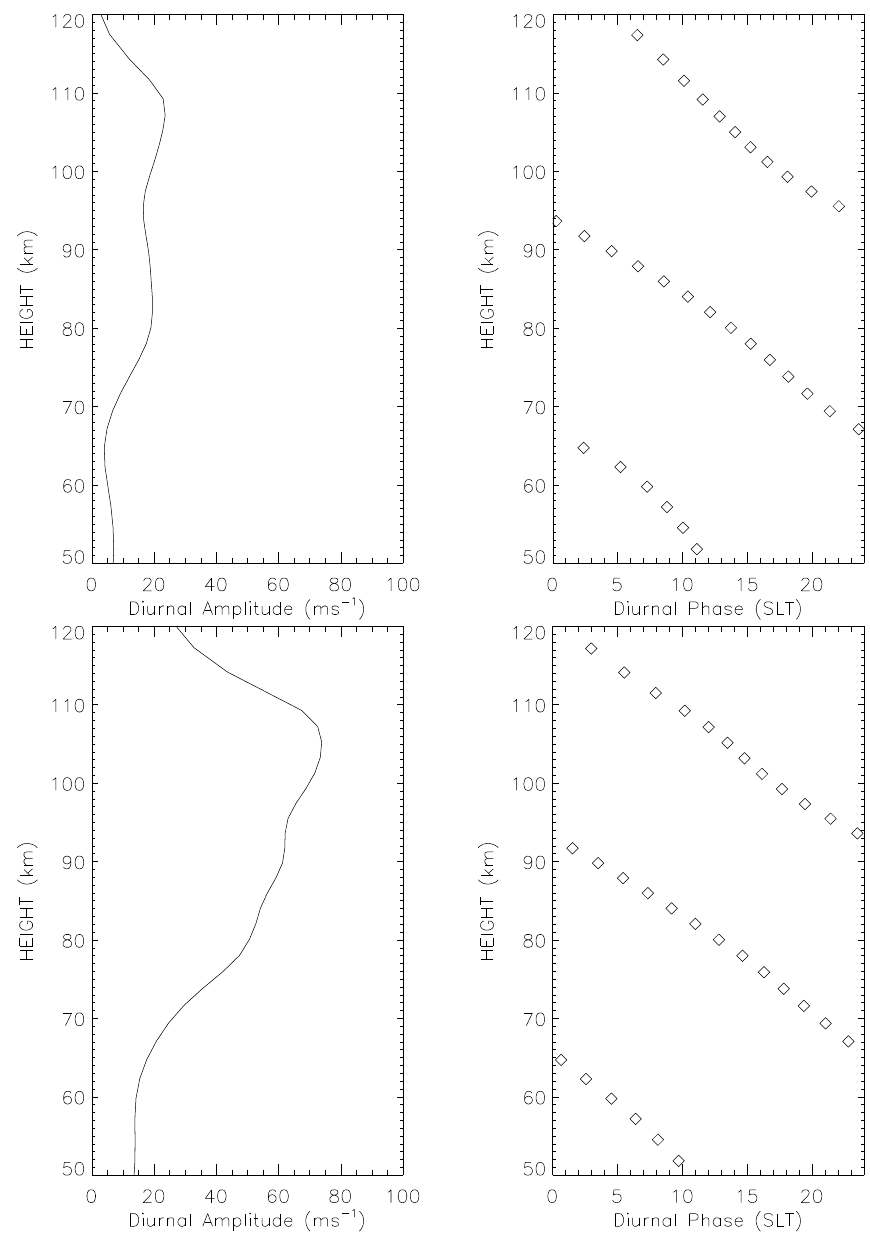
Fig. 6. Meridional winds (ms − 1 ) at 12:00LT for March, as measured by HRDI (top) (from Yudin et al., 1997), with southward winds shaded, and the diurnal amplitude structure of meridional winds (ms − 1 ) as measured by WINDII (bottom) (from Akmaev et al.,